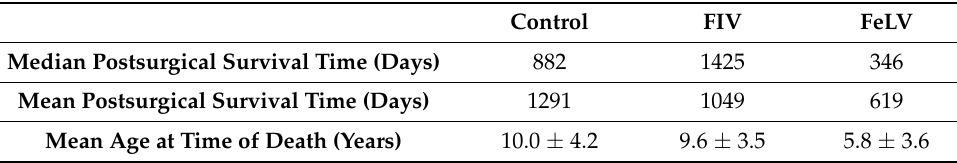
Table 7. Overall postsurgical survival time and mean age at time of death of the 111 cats with chronic gingivostomatitis, according with retroviral disease